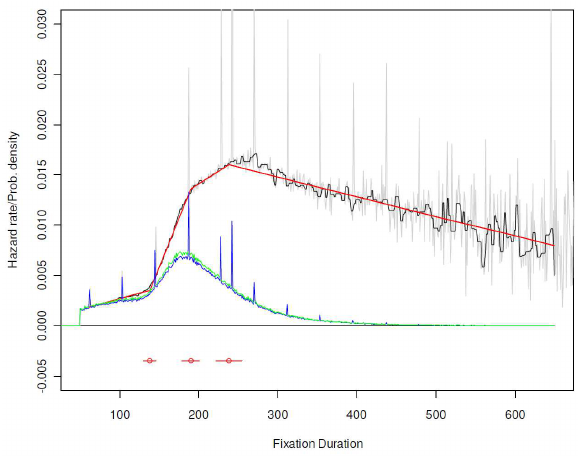
Figure 2. Hazard Function and the Probability Density Function: The Dundee Corpus A number of observations are noteworthy in Figure